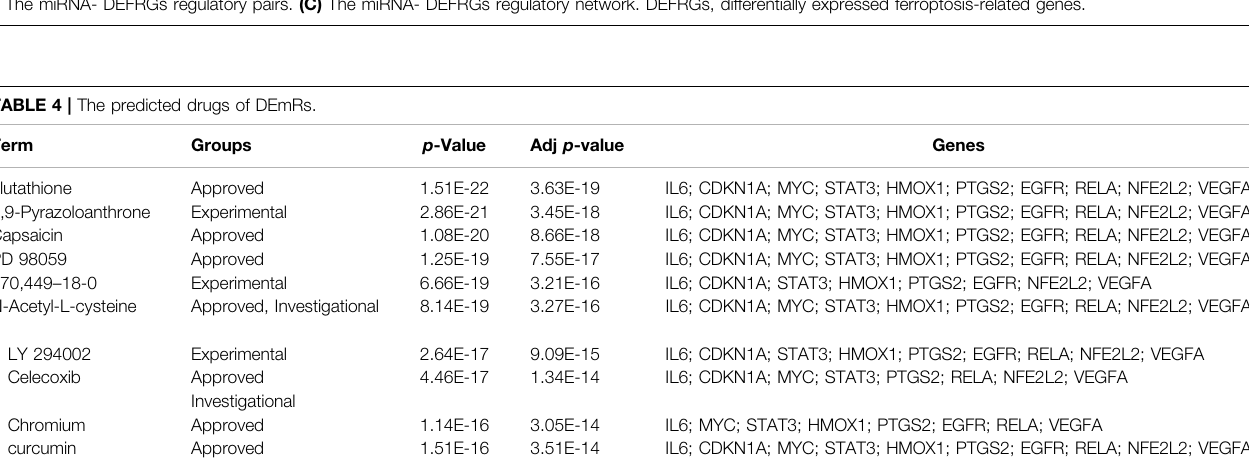
( Figure 4B ), while Molecular Functions (MF) included “